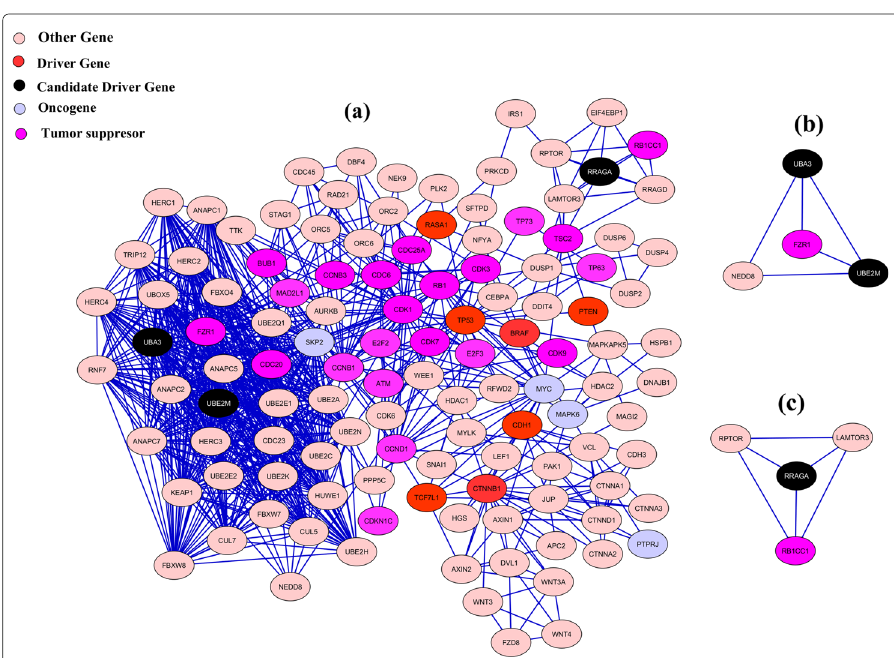
Fig. 3 Hereditary gastric cancer network. The STRING graph for hereditary Subtype of Gastric cancer based on the genes archived by our algorithm